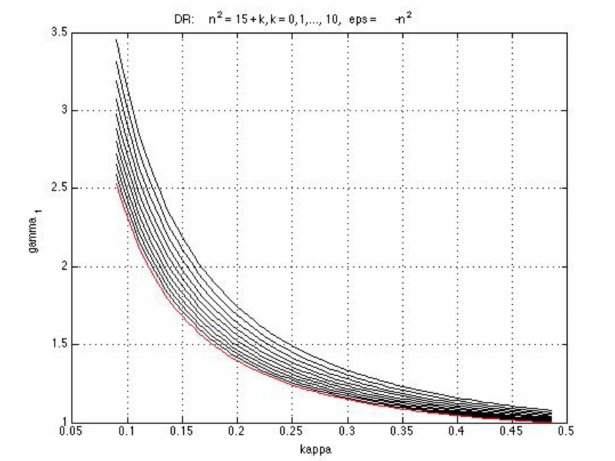
Figure 6: Plots of F d = F d ( γ ) (blue) and G d = G d ( γ ) (red) of DE (9) showing the evolution of the fundamental DR surface mode for (cid:15) = − 16 at κ = 0 . 86 (upper curves) and 1.3 ( (lower curves).